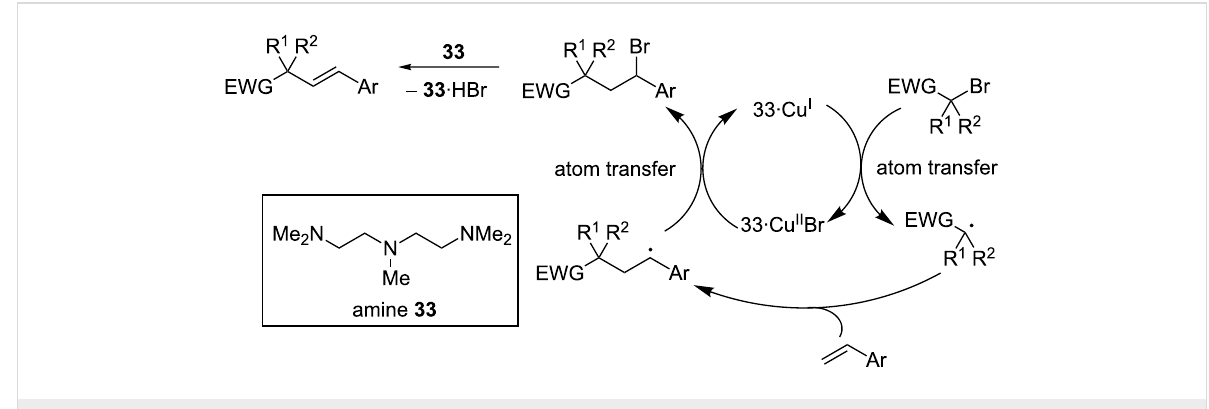
Scheme 9: Proposed mechanism of the copper-catalyzed alkenylation reaction.